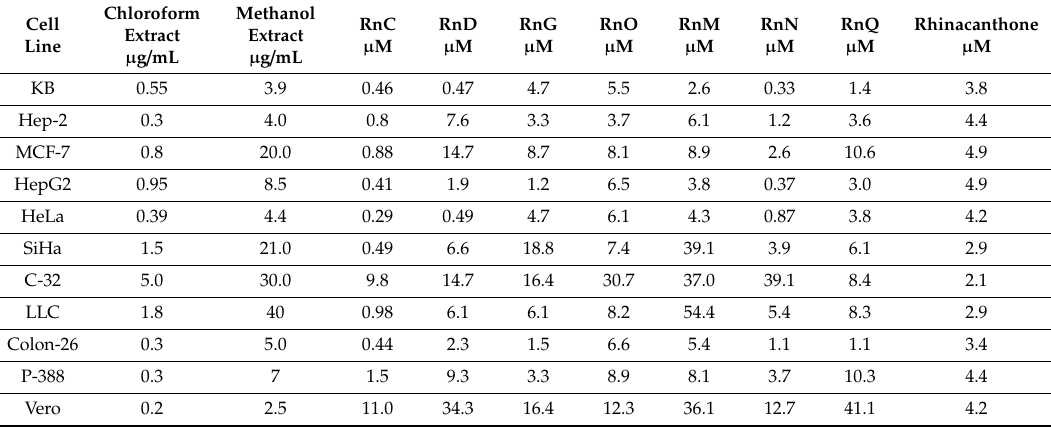
Table 3. IC 50 values for various extracts and isolated compounds from Rn in a range of cancer cell lines. Data extracted from Wu et al. 1998 [17], Siripong et al. 2006 [61] and Siripong et al. 2009